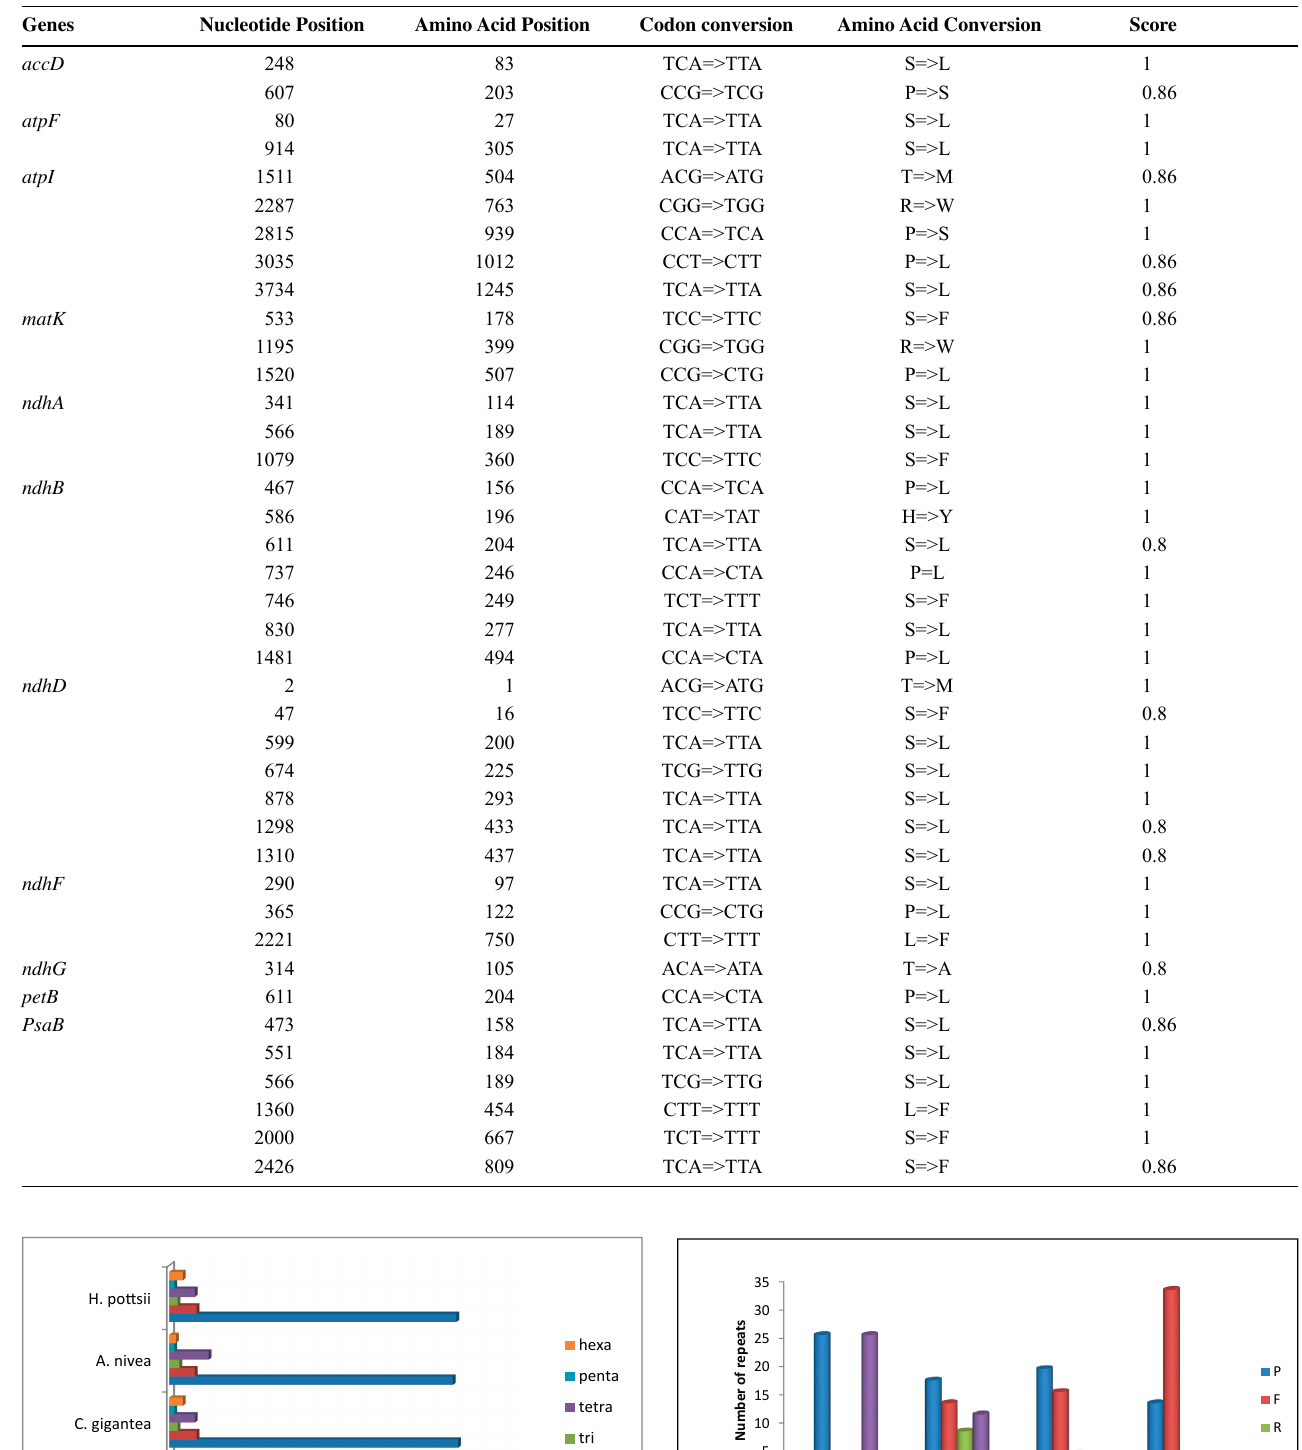
Tab. 6: Number of predicted RNA editing sites in the cp genome of Caralluma quadrangula. Genes